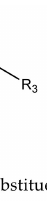
Figure 4. Core structure of cathinone derivatives.